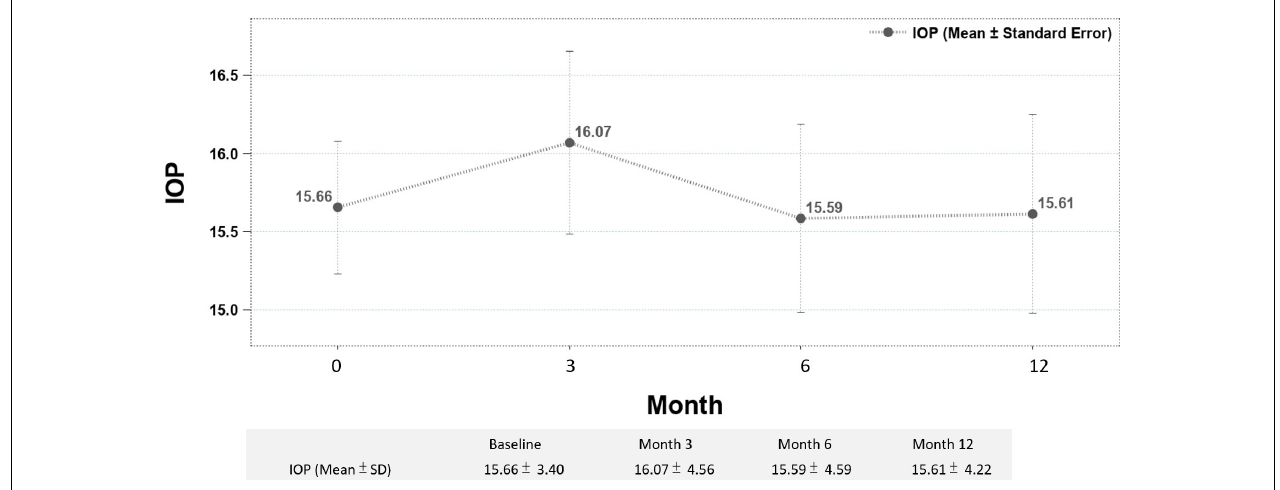
FIGURE 4 | Serial IOP change during treatment, revealing no obvious